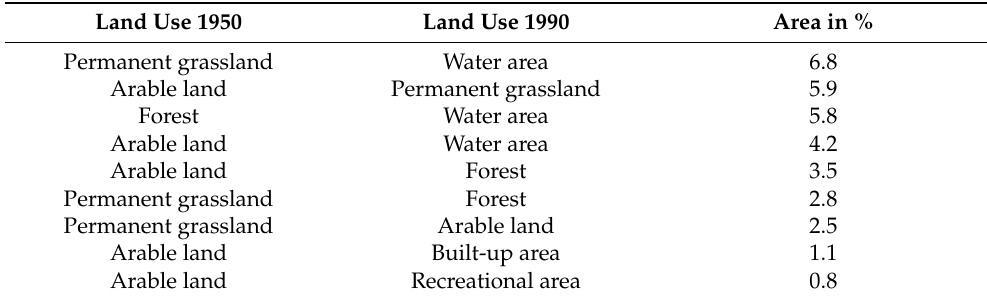
Table 5. The proportion of the land-use change processes that occurred between 1950 and 1990 in the existing water reservoirs and their